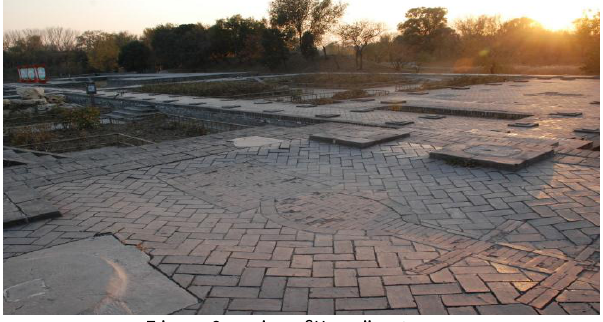
Figure 6. ruins of Han jing tang,